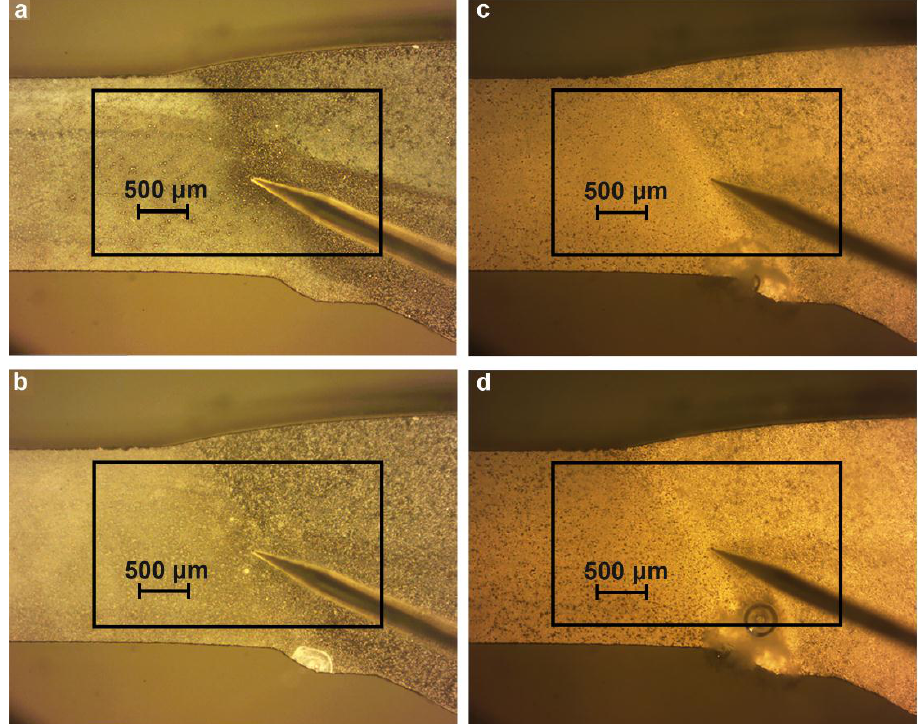
Figure 9. Images obtained by optical microscopy of the welded joint area after specimen exposure for ( a ) 1.5, ( b ) 4.5, ( c ) 81, and ( d ) 87 h to 0.5 M NaCl. The corrosion process started to move from the bottom part of the studied area to the bulk of the material within the weld interface.